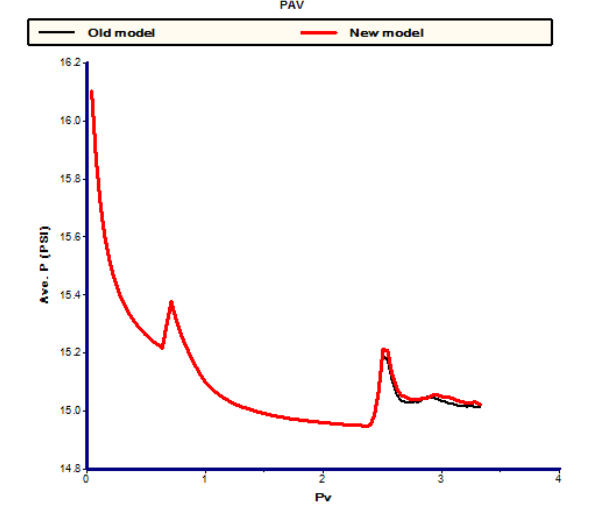
Table 4: Simulation input parameters for base case model of frac- ture block experiment Figure 10: Average pressure vs. injected pore volume